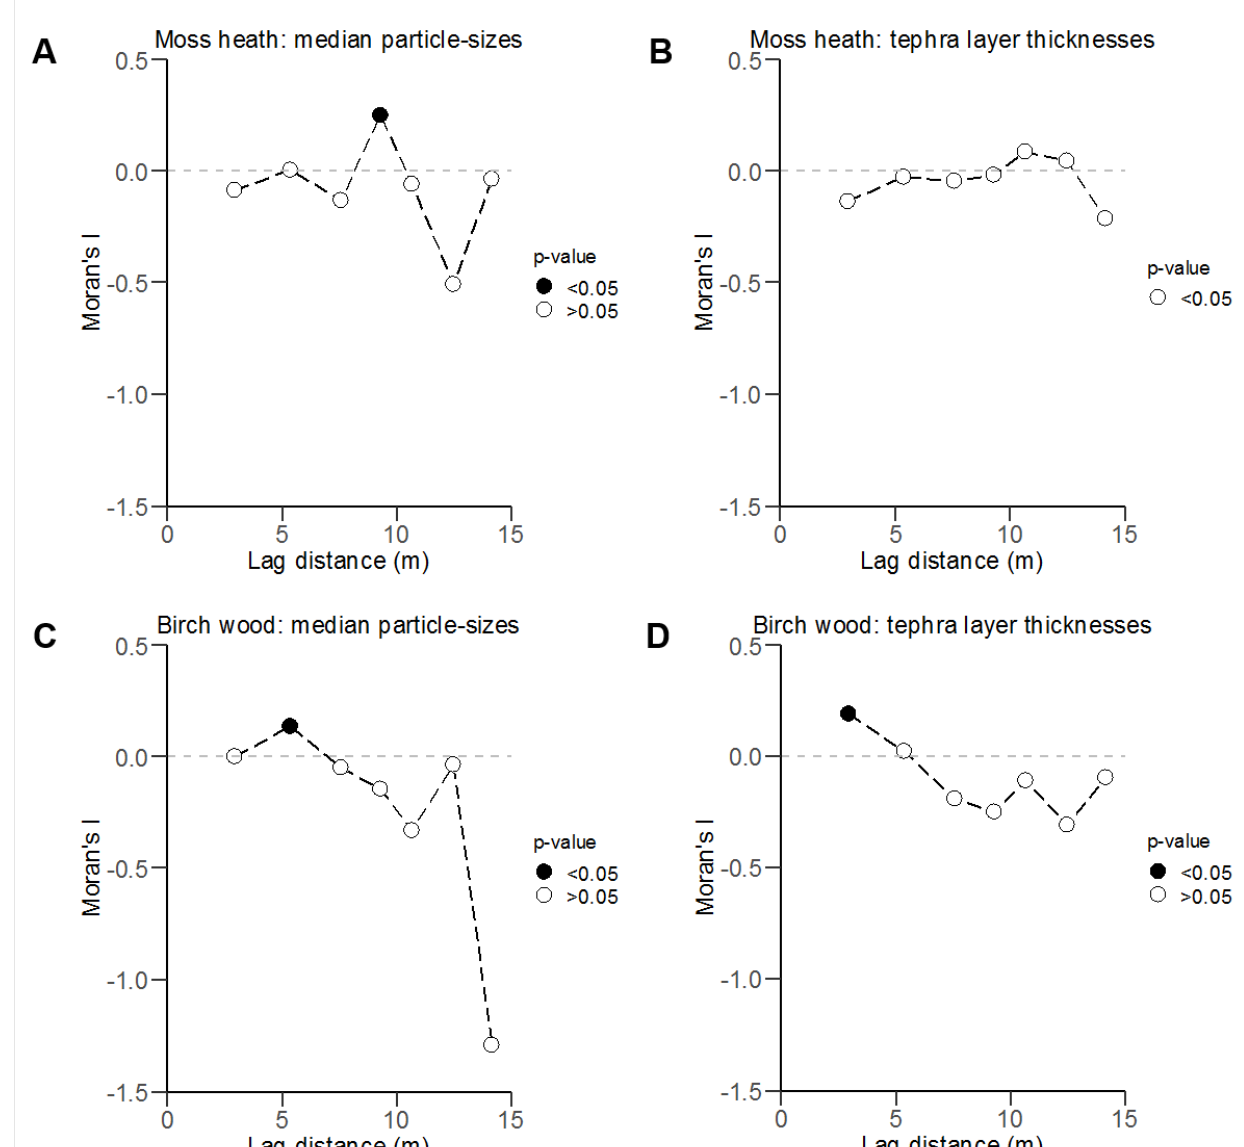
Figure 6: Correlograms showing the Moran’s I value and p-values at different distance separations for measurements of the G2011 tephra at Fossdalur. [A] Median particle-sizes in moss heath, [B] layer thicknesses in moss heath, [C] median particle- sizes in birch woodland, and [D] layer thicknesses in birch woodland. Black points indicate significant spatial autocorrelation ( p